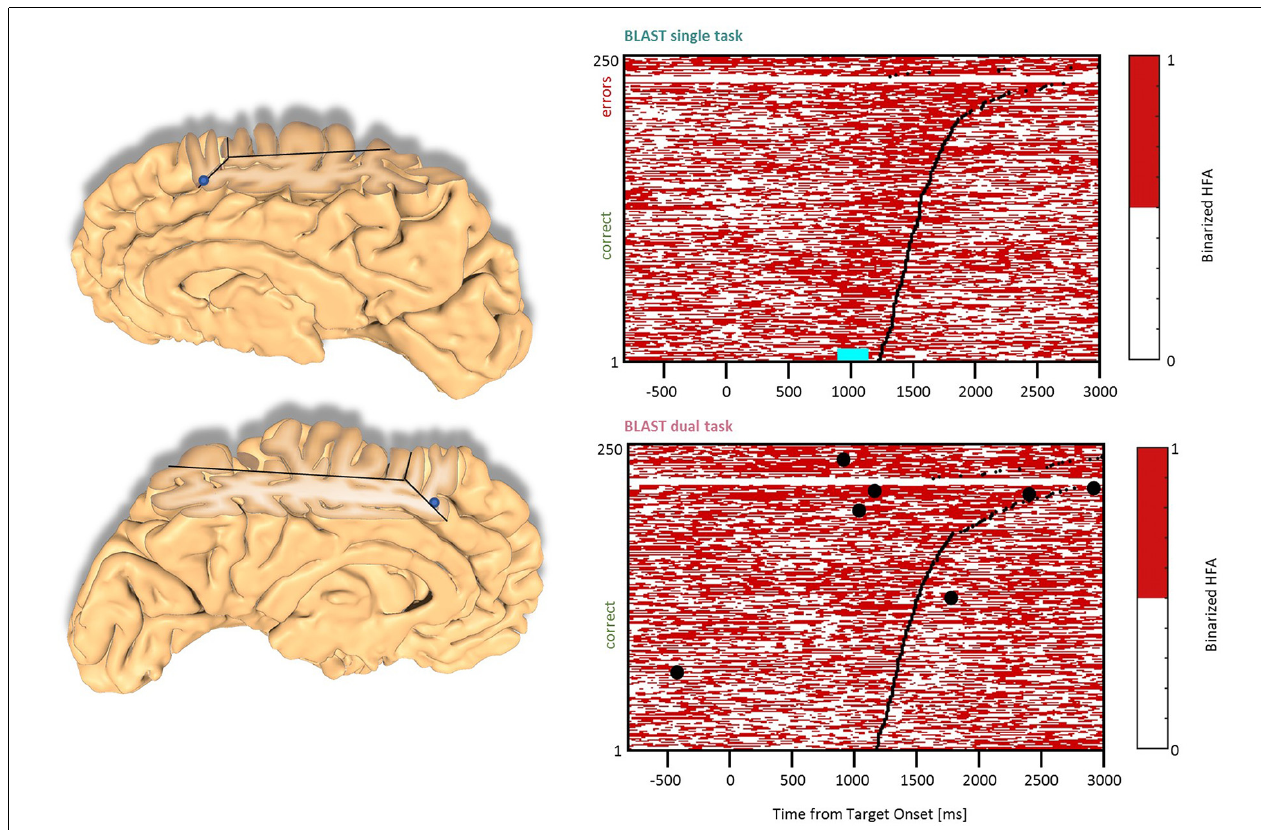
FIGURE 7 | Interference in the Anterior Cingulate Cortex and the Pre-Supplementary Motor Area. Sites with interference between T1 and T2 are displayed at their precise anatomical location onto a 3D representation of the participant’s brain. The matrix representation reproduces the display of Figure 2 , for the single-task and dual-task conditions for one of the sites. Patients id [Px] and iEEG site names, from left to right and top to bottom: S2 [P7]; Z’2 [P5] (matrix displayed)